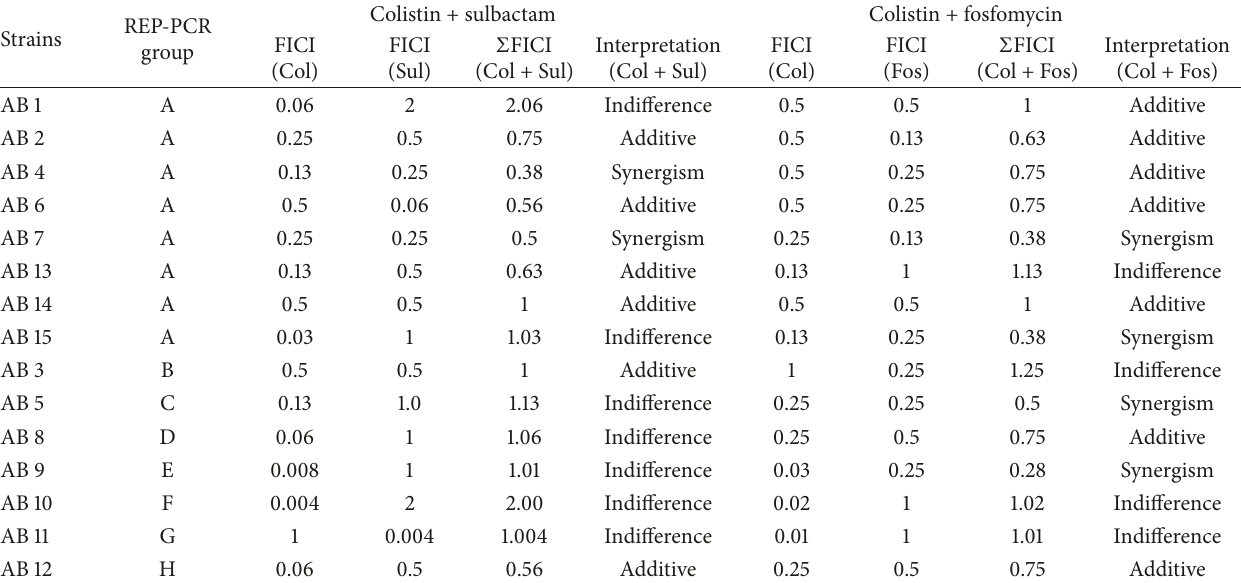
Table 2: Antimicrobial combination test against carbapenem-resistant A. baumannii clinical isolates using chequerboard technique.